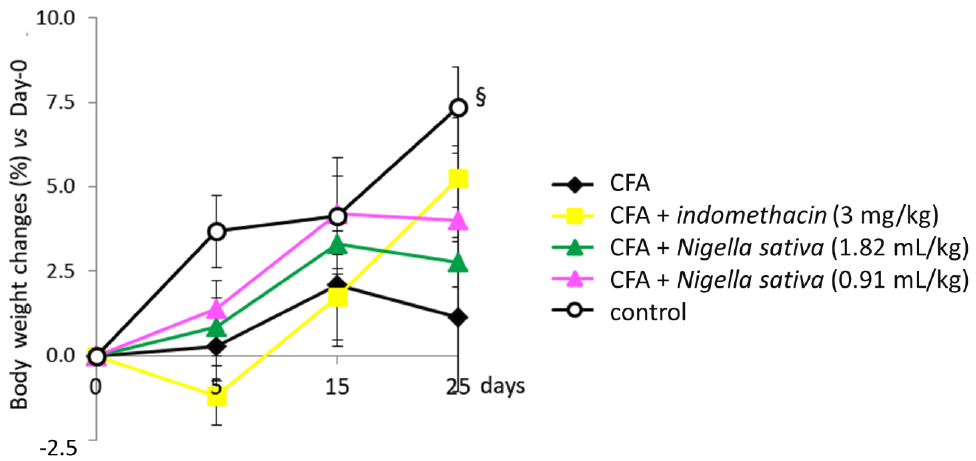
Figure2. E ff ect of Nigella sativa oil ondisease progression in CFA-induced arthriticrats. CFA-immunized Figure 2. Effect of Nigella sativa oil on disease progression in CFA-induced arthritic rats. CFA- rats (on day 0) received Nigella sativa oil (1.82 or 0.91 mL / kg), indomethacin (3 mg / kg) or vehicle immunized rats (on day 0) received Nigella sativa oil (1.82 or 0.91 mL/kg), indomethacin (3 mg/kg) or